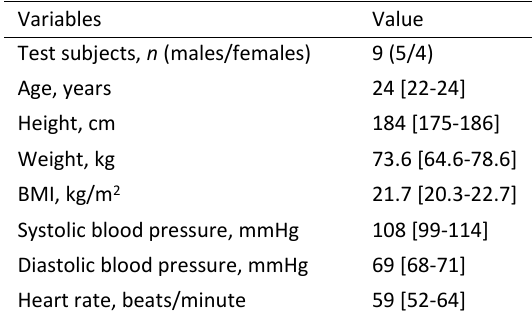
Table 1: Main characteristics of the participants. Values are numbers or median [Q1-Q3]. BMI indicates the body mass index (weight/height 2 ).